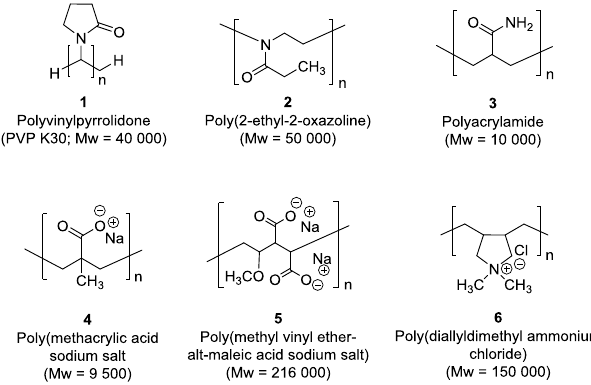
Figure 1. Structures of the polymers ( 1 – 6 ) used as stabilizers for the CoNPs.